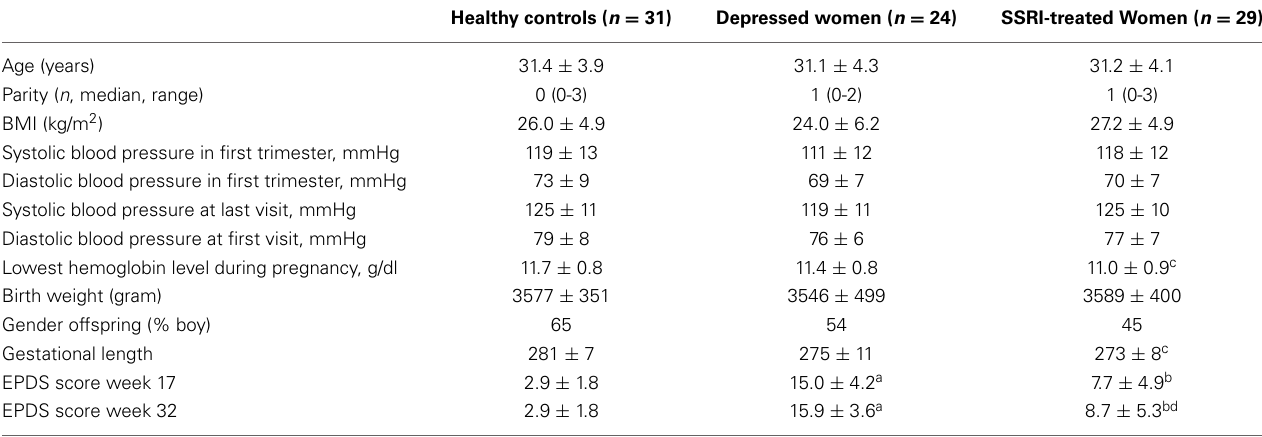
Table 2 | Validation demographic variables in the depressed group, SSRI group, and healthy